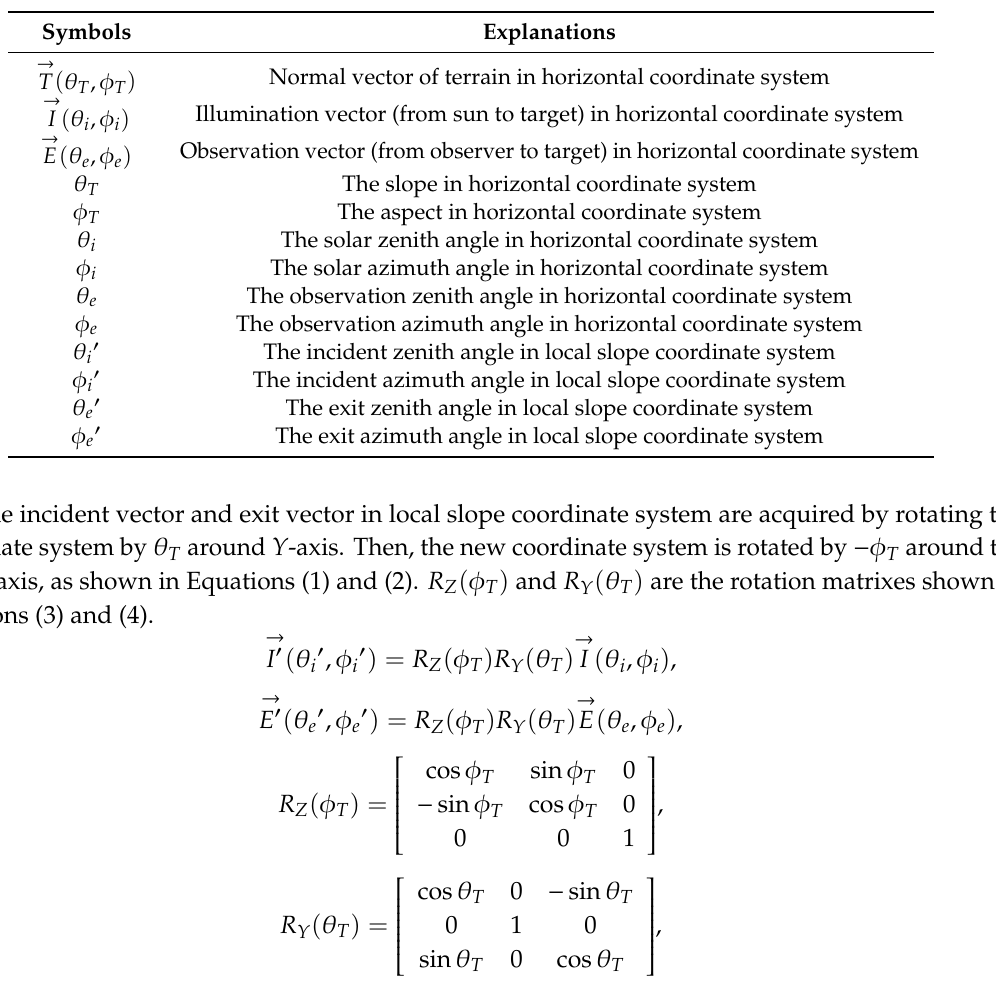
Figure 1. The geometric model for illumination and observation [24]. Table 1. Notations used for the description of radiance transfer process.